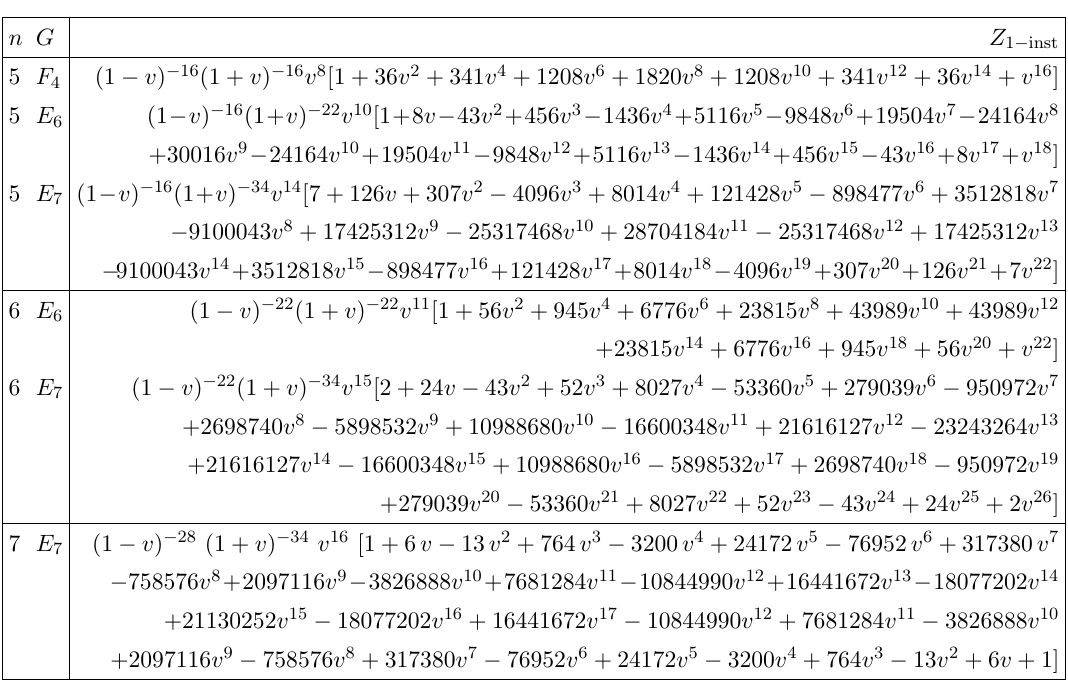
with n = 5 ; 6 ; 7, with chemical n